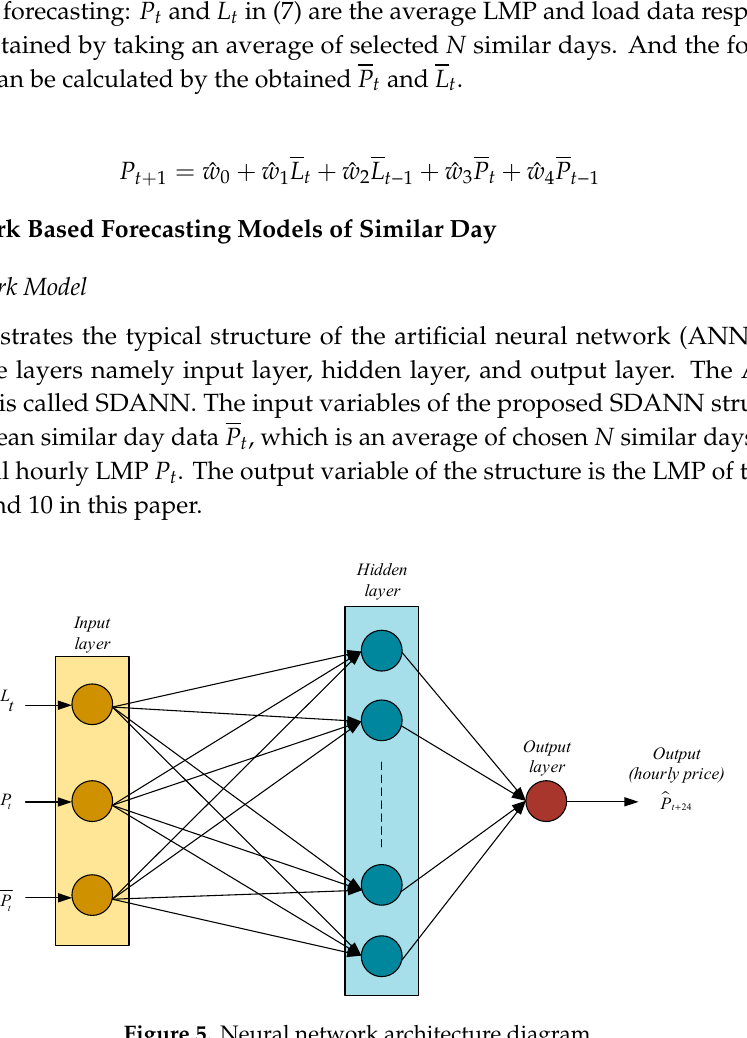
Figure 6. Price forecast based on neural network. (a) Training: Selecting similar day interval, d , it is 45 days in the paper, and therefore the load and LMP data have 134 days (excluding the load and LMP of reference day.) as input training data. According to Figure 2, input training data is based on the reference date which is point A. The